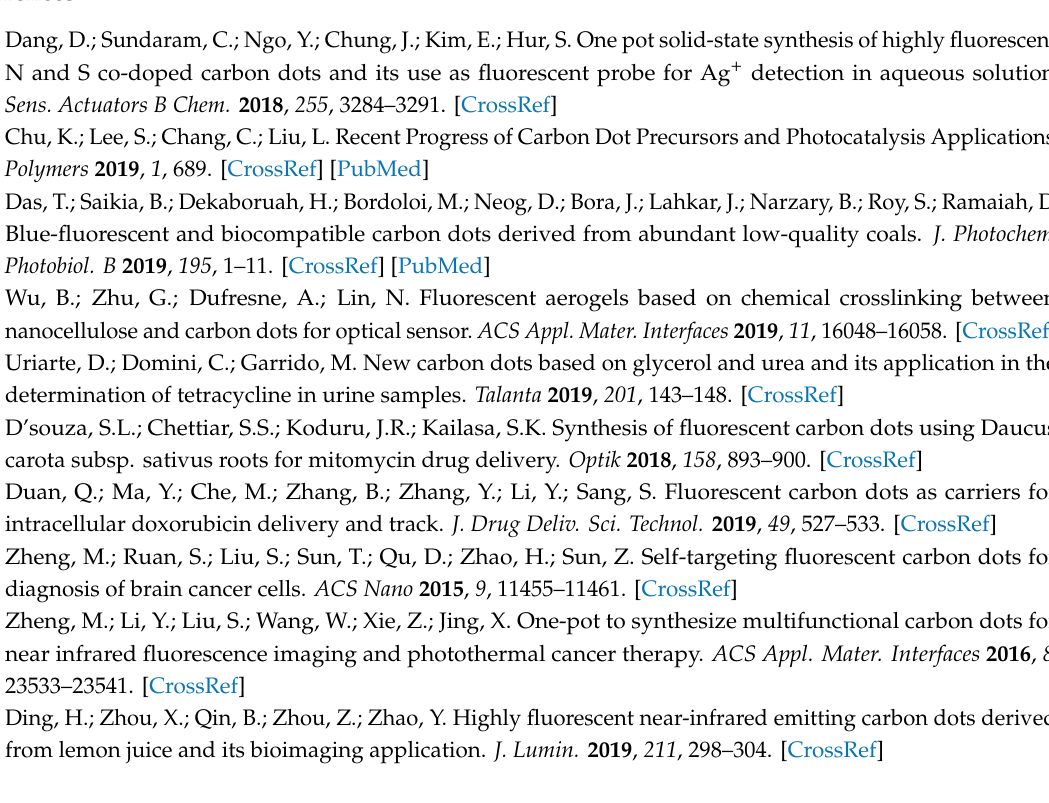
Figure S1: R-CDs Fluorescence spectra of four samples obtained by separation., Figure S2: XRD patterns of the R-CDs and Y-CDs., Figure S3: Raman spectra of the R-CDs and Y-CDs, Figure S4: (a) R-CDs and (b) Y-CDs with XPS full spectrum, Figure S5: (a) C1s and (b) O1s spectra of R-CD, (c) C1s and (d) O1s spectra of Y-CDs, Figure S6: Sensitivity investigation of the Y-CDs for CV detection (samples concentration: 10 µ M) ,Figure S7: The overlap between absorption spectrum of CV and the emission spectra of